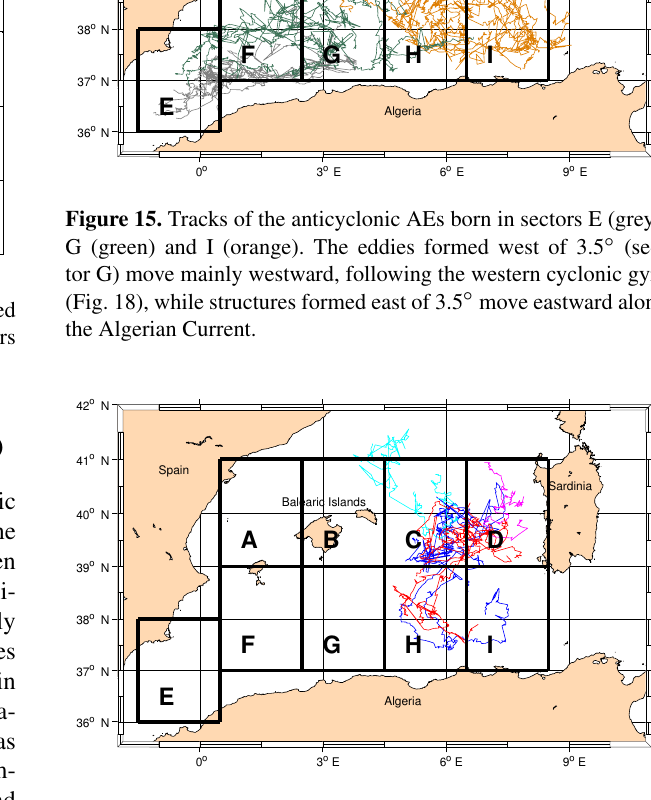
Figure 16. Tracks of the anticyclonic FEs born in sectors C (blue and cyan) and D (red and magenta). Blue and red lines indicate the eddies which follow the cyclonic loop and move southward, while red and magenta lines indicate the structures which move north-